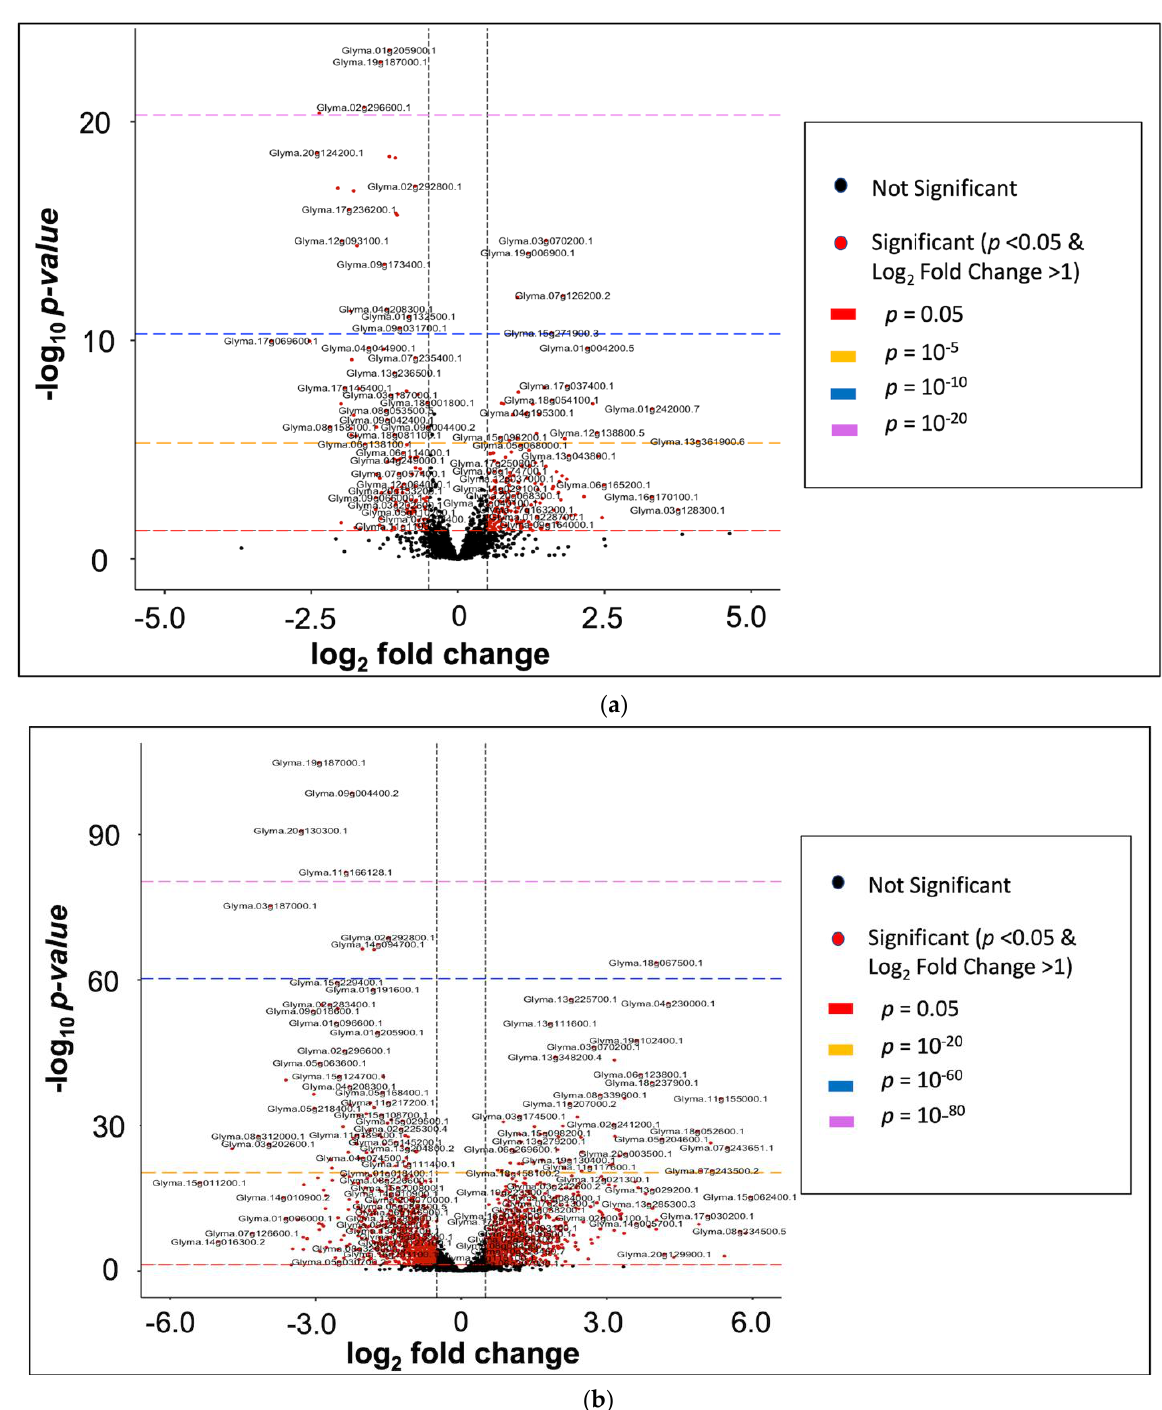
Figure 7. Enhanced Volcano plot of differentially expressed genes (DEGs) using gene transcript reads with counts greater than 2000 ( a ) in the 100 ng/L vs. control analysis. Note: Two genes (1 upregulated and 1 downregulated) fall outside the x -axis range. (See complete gene list in Supplemental S3—Sheet 1) and ( b ) in the 1 mg/L vs. control analysis. Note: Eight genes fall outside the x -axis range i.e., 2 upregulated and 6 downregulated (See complete gene list in Supplemental S3—Sheet 2). Red points indicate significant DEGs at p < 0.05 and log 2 -fold change > 1; log 2 -fold change < 0 = downregulated genes, log 2 -fold change > 0 = upregulated genes; Long dashes indicate different p -values